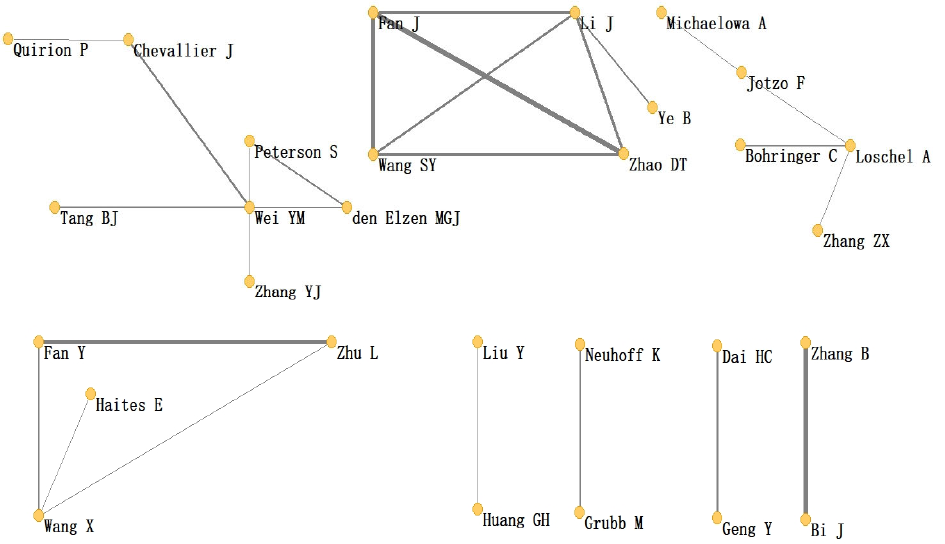
Figure 3. Co-operation among productive Figure 3. Co ‐ operation among productive authors.